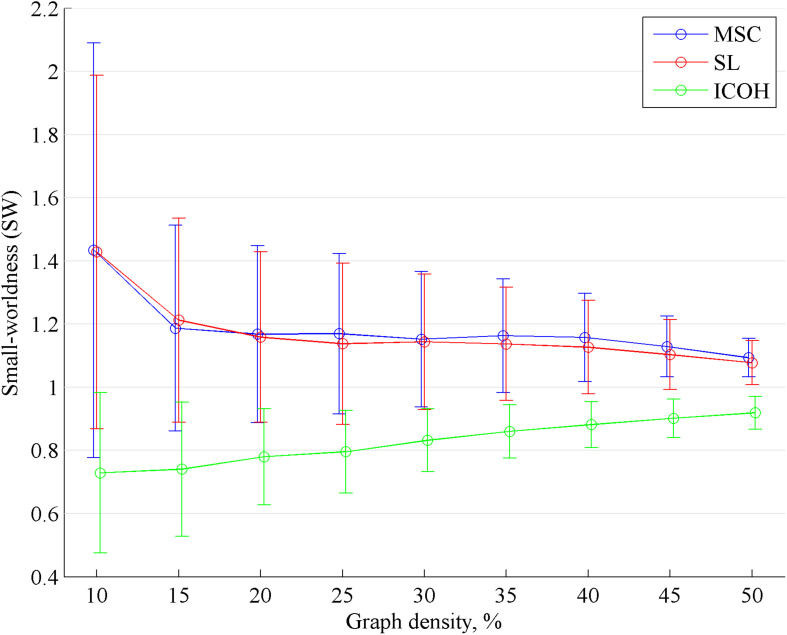
Small-worldness (SW) depending on graph density. The mean and standard deviation values are shown for SW, calculated from MSC, SL and ICOH. SWICOH is significantly lower than SWMSC and SWSL.